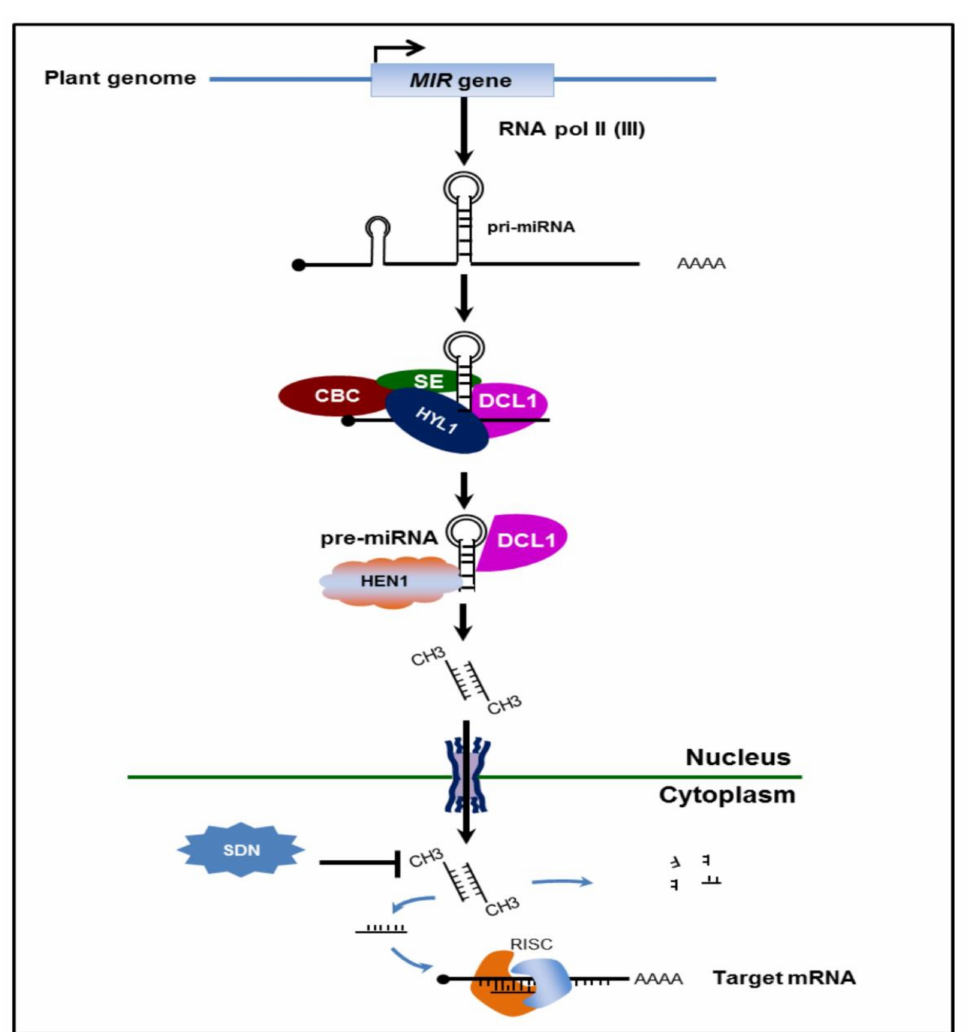
Figure 1. Scheme of plant microRNA biogenesis. Plant microRNA are transcribed by RNA poly II from the transcripts located in intergenic regions. Pri-miRNA was stabilized by DDL, then binds with Serrate (SE), Hyponasty Leaves (HYL1), and cap-binding complex (CBC), and processed by DCL1 into pre-miRNA. The pre-miRNA duplex is methylated by Hua Enhancer 1 (HEN1) and transported from the nucleus to the cytoplasm by HASTY. The guide miRNA strand binds AGO1 and is loaded into the RISC complex to carry out the silencing